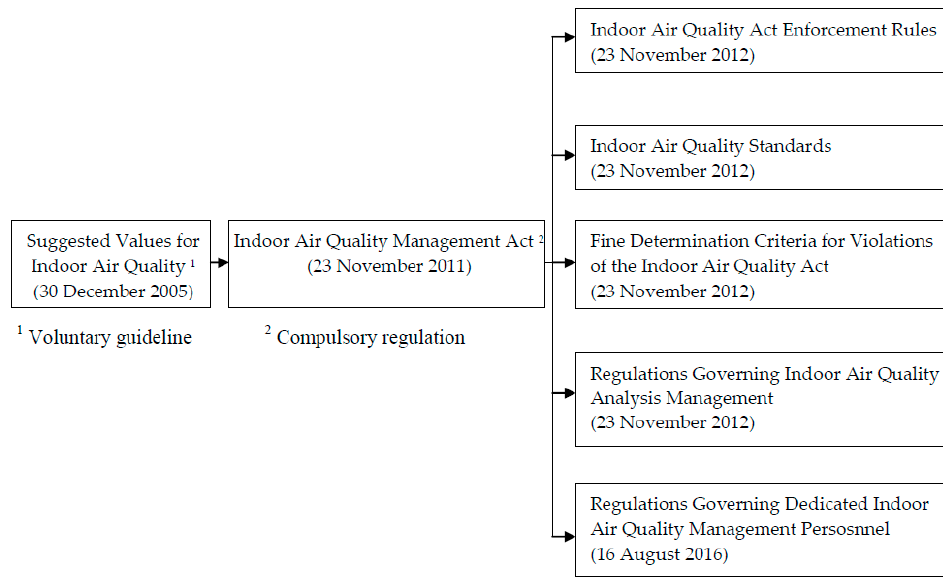
Figure 1. Indoor air quality (IAQ) regulations in Taiwan, providing the authority for the Environmental Protection Administration (EPA).